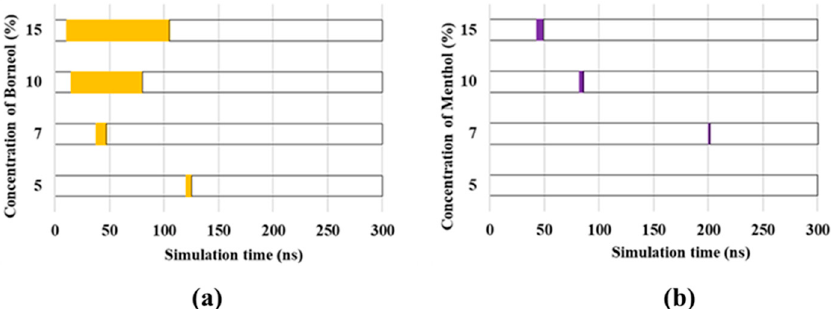
Figure 6. Molecular trajectory of borneol ( a ) and menthol ( b ) at different PE concentrations for 300 ns. Transient pore formation is depicted in purple and yellow, which, respectively, represents the time the transient pores were first observed and the time the transient pore disappeared.